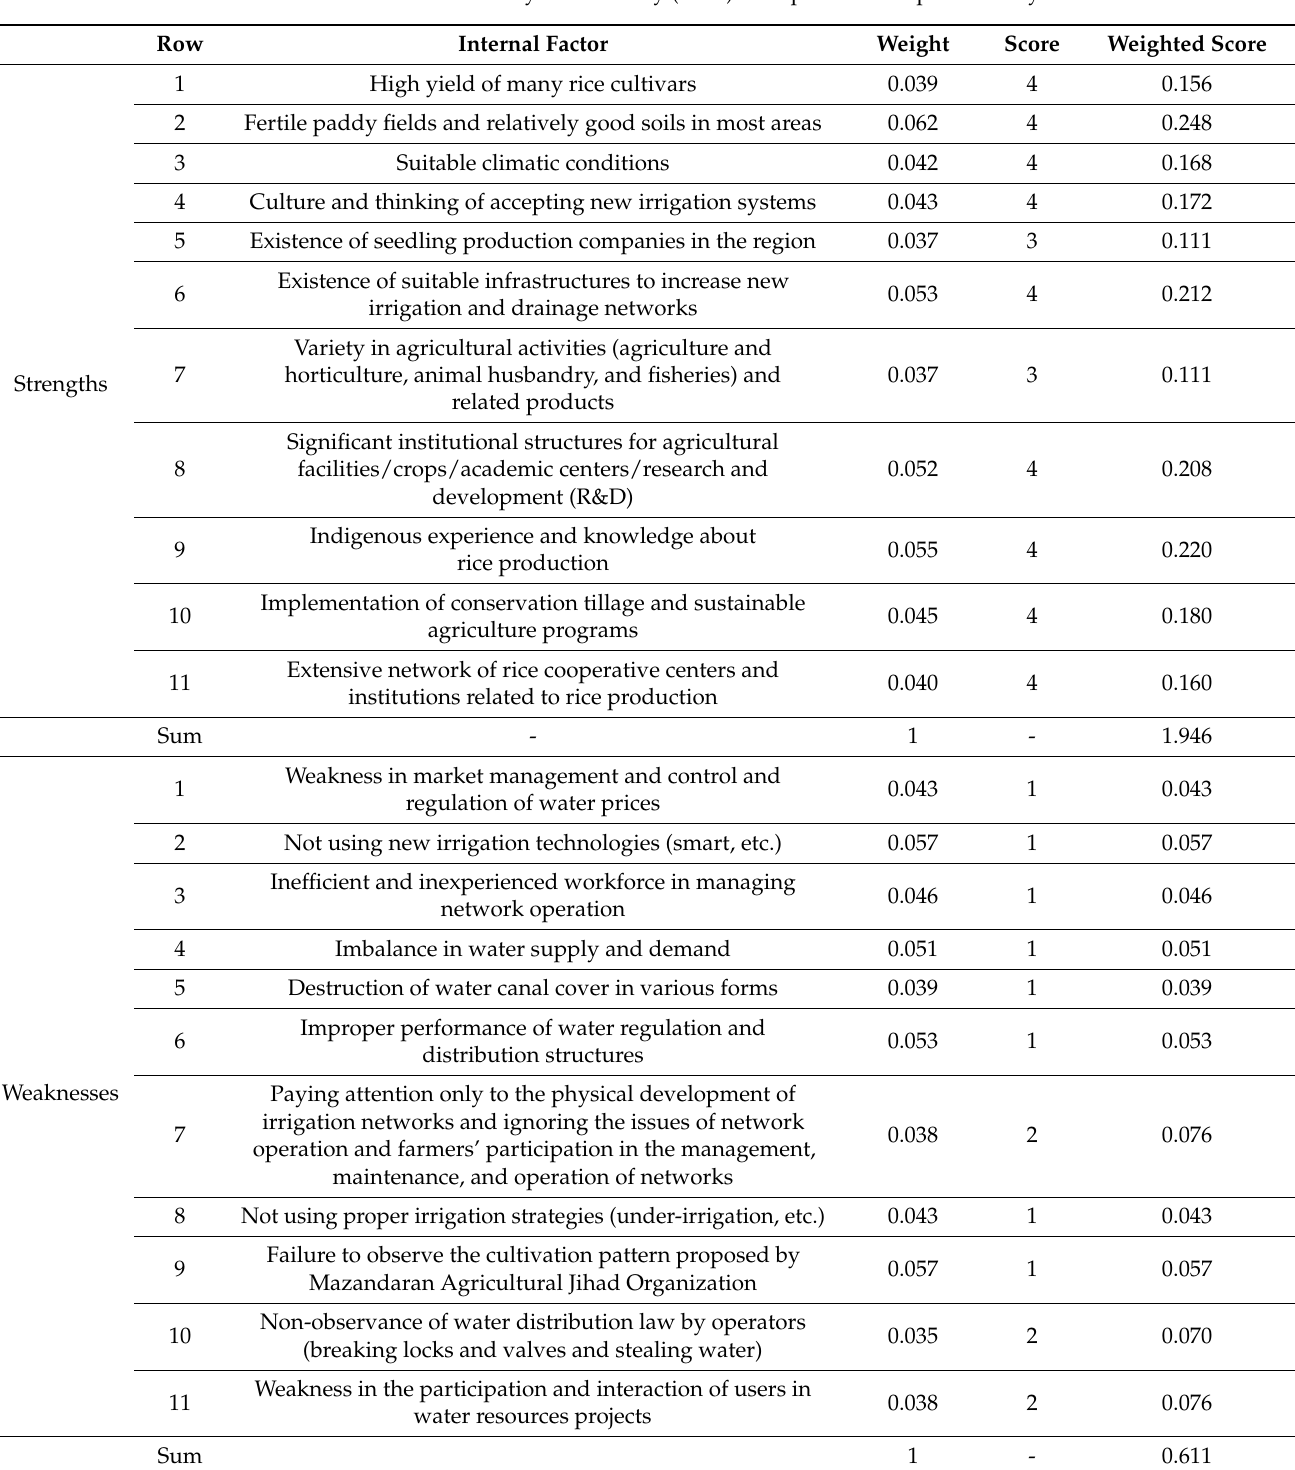
Table 1. Internal Factor Analysis Summary (IFAS) to improve water